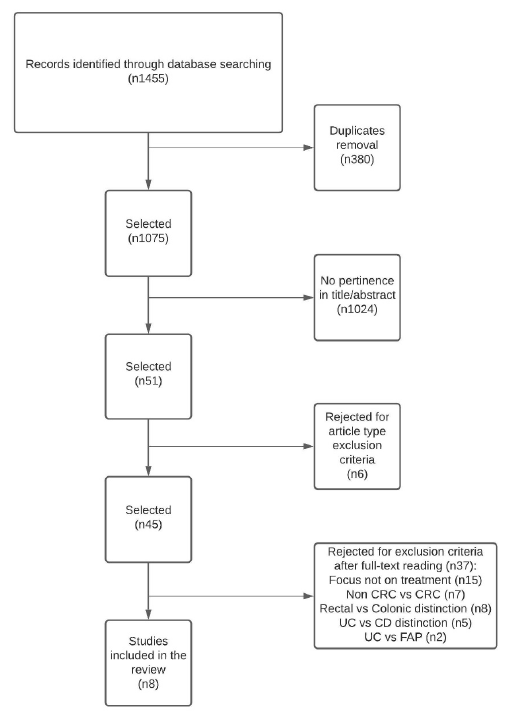
Figure 1. Flow diagram for assessment of studies identified by the search strategy.